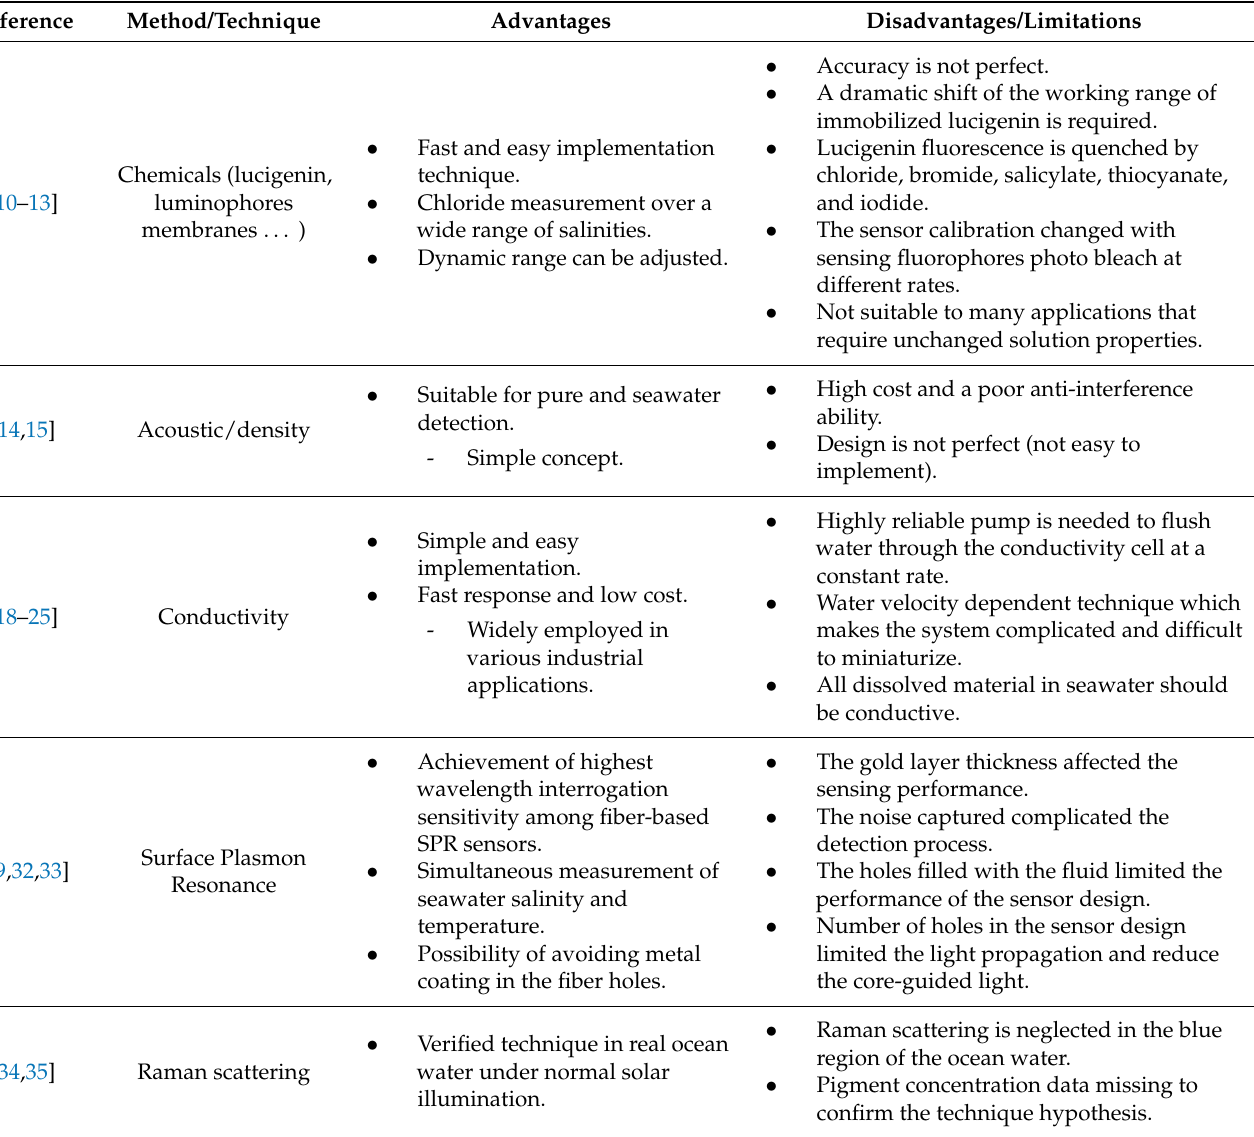
Table 1. Comparison table detailing the advantages and limitations of techniques used for pure and salty water salinity